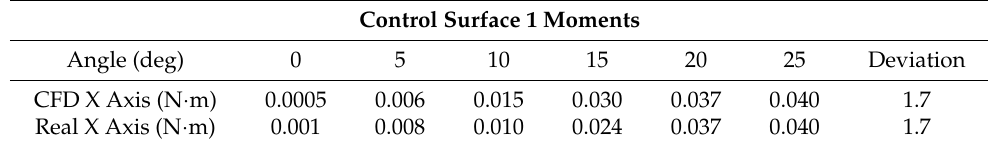
Figure 26. Experimental, CFD simulation and dynamic requirements comparison for both control surfaces. ( a ) Experimental vs. CFD moments for Control Surface 1. ( b ) Experimental vs. CFD moments for Control Surface 2. Table 5. Moments generated by Control Surface 1 at different deflection